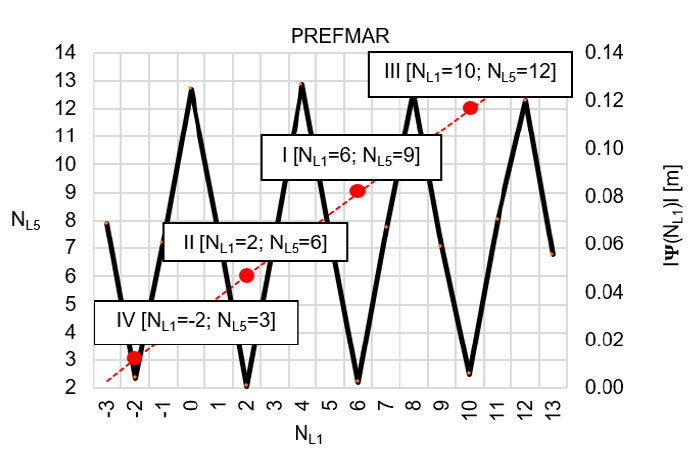
Figure 9. Search area of ambiguities in N L 1 N L 5 system, for (cid:101) N L 1,0 = 5.141 and (cid:101) N L 5,0 = 8.349, with the